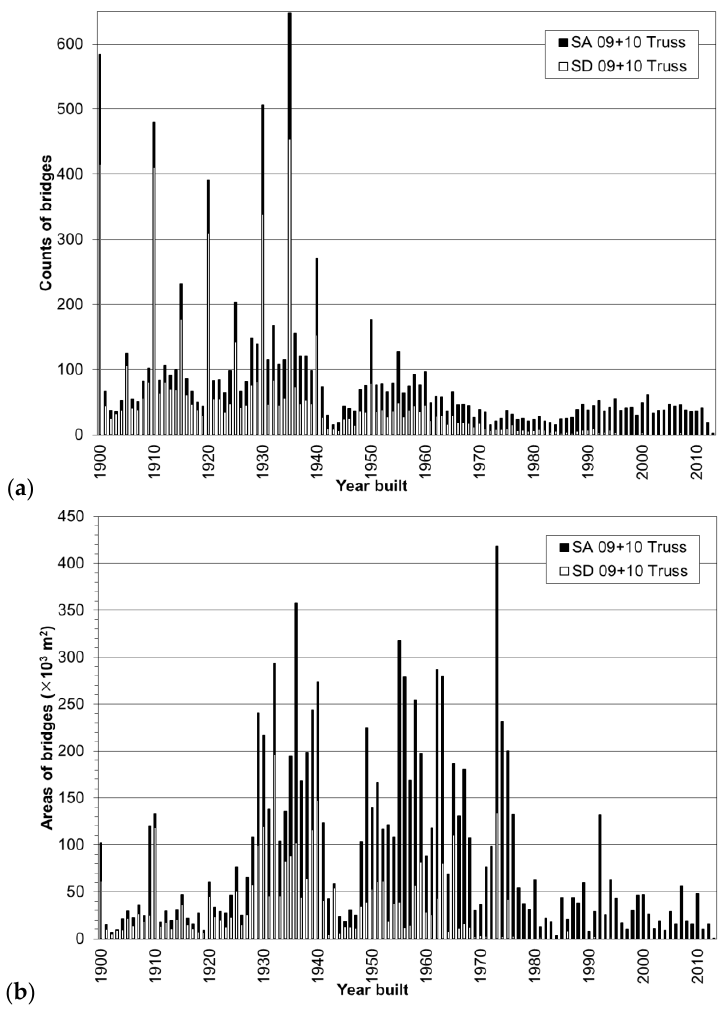
Figure 4. Distribution and SA to SD ratio of truss (types 09 and 10) bridges. (a) Counts and (b) Areas.